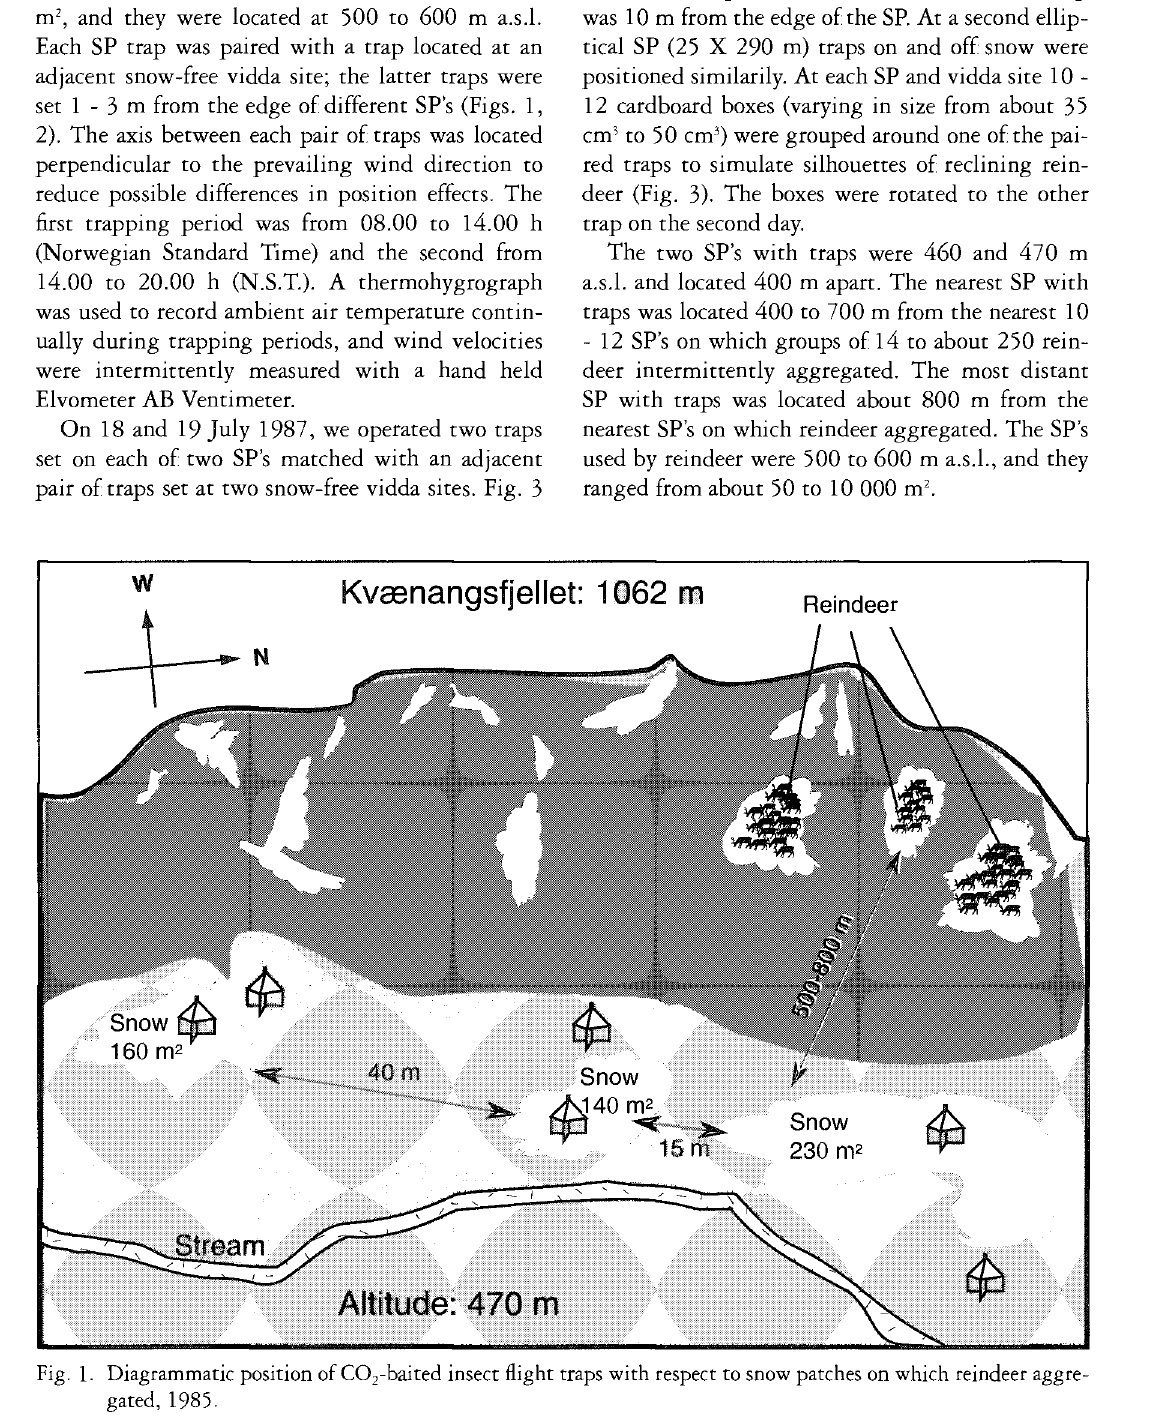
Fig. 1. Diagrammatic position of C0 -baited insect flight traps with respect to snow patches on which reindeer aggre 2 gated,